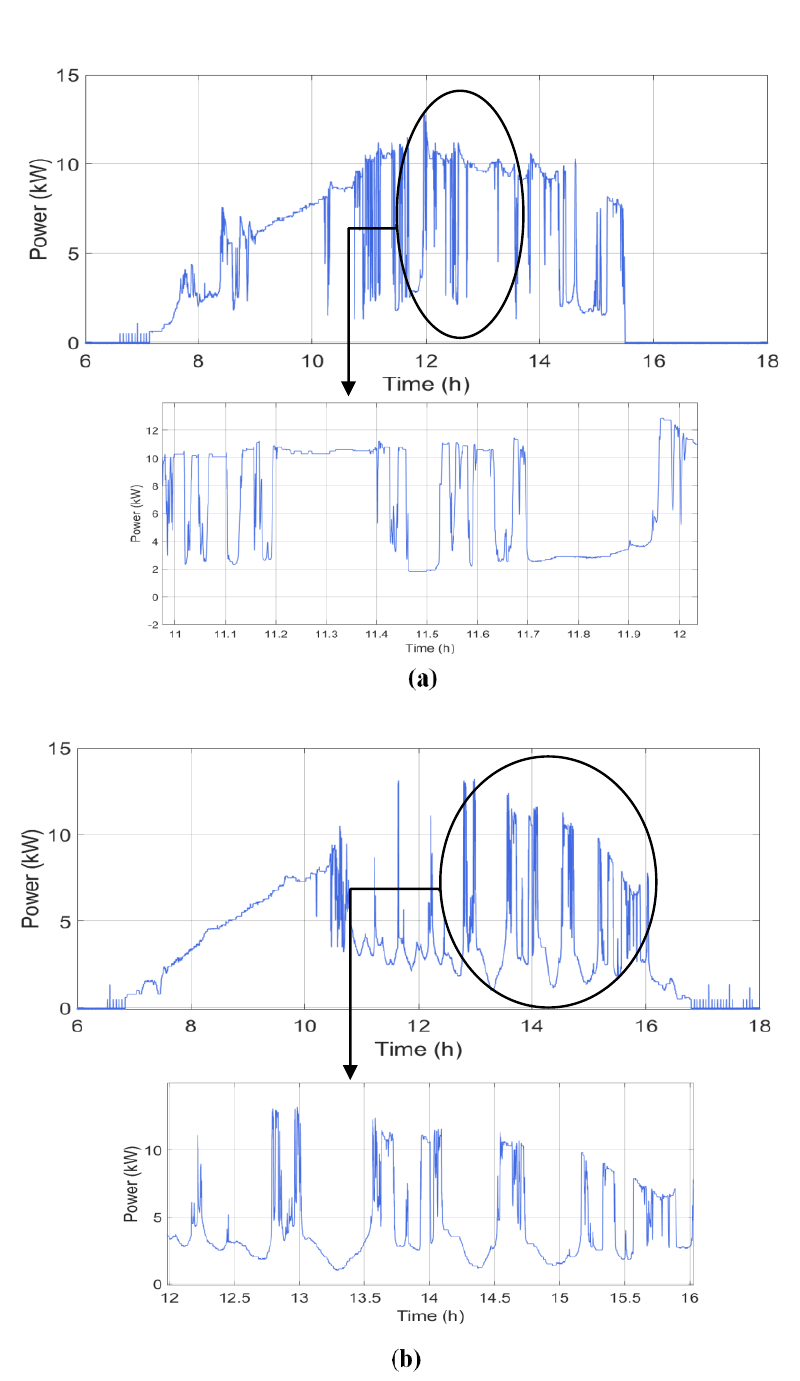
Figure 5. Photovoltaic power output: ( a ) most critical day and ( b ) average day.